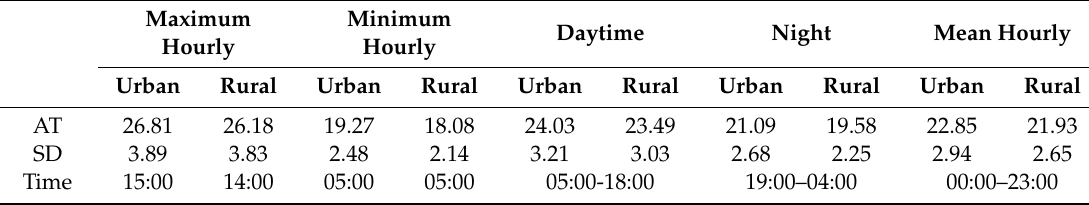
Figure 4. Hourly variations of maximum (Max), minimum (Min) and mean air temperatures of study area, rural area, urban area, and the averaged mean air temperature of four sample weather stations. Table 3. Urban, rural air temperatures (AT) (°C) for the period of August 1–31, 2015 for 195 stations. Table 3. Urban, rural air temperatures (AT) ( ℃ ) for the period of August 1–31, 2015 for 195 stations.